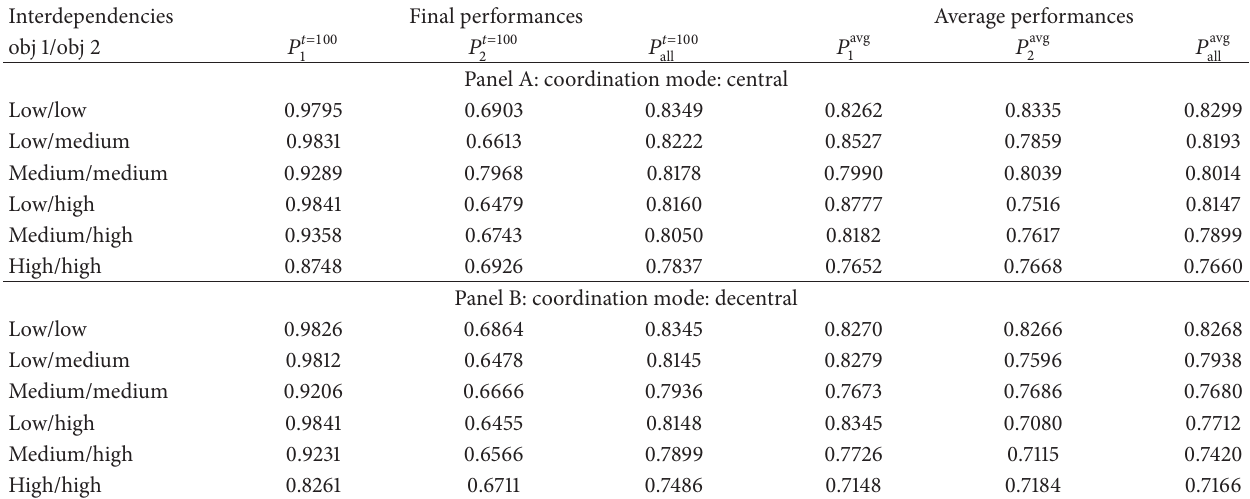
Table 4: Long-run schism.